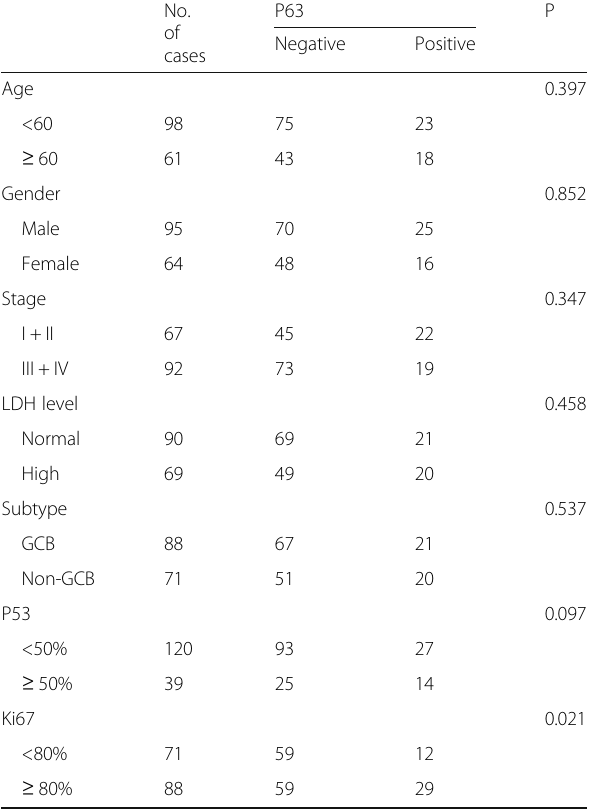
Table 1 Clinical-pathological characteristics of the patients and P63